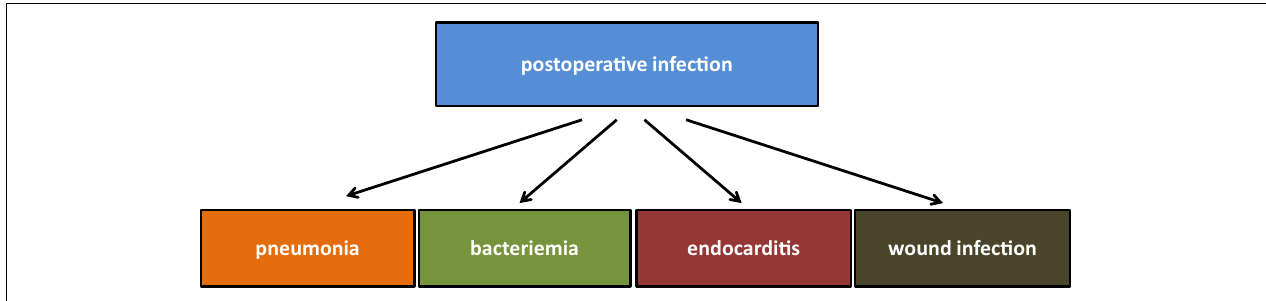
FIGURE 1 | Possible infections after cardiac surgery .